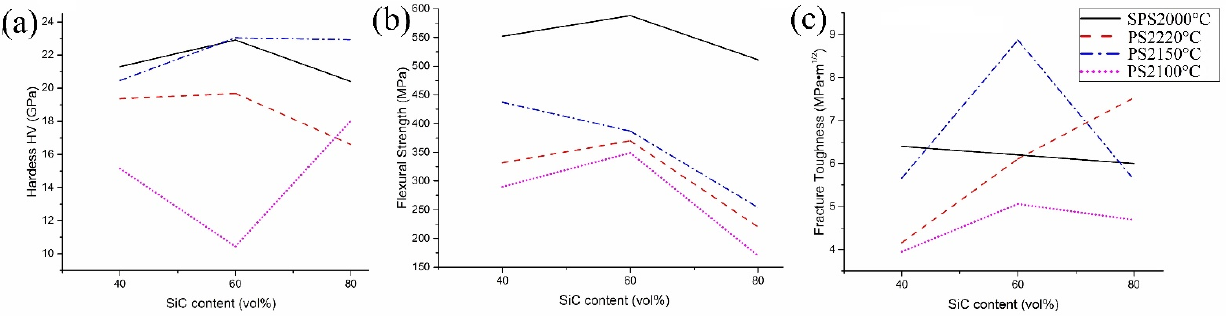
Figure 9. Mechanical properties of SiC-TiB 2 -TiC composites sintered by SPS and PS: (a) Hardness, (b) Flexural Strength, and (c) Fracture toughness vs. SiC content (vol.%). ( b ) Flexural Strength, and ( c ) Fracture toughness vs. SiC content